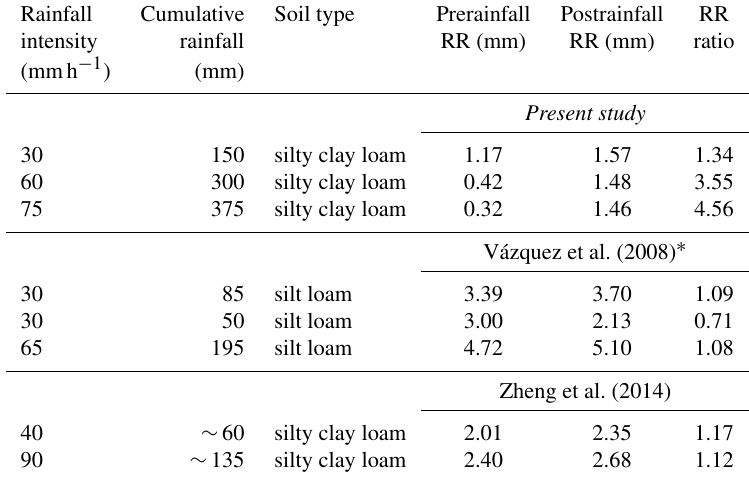
Table 1. Summary of the rainfall-induced change in the RR index in the experimental tests of this study, as well as in experiments reported in the literature. Smooth conditions refer to initial microroughness less than 5mm. Cumulative rainfall amounts are also provided.